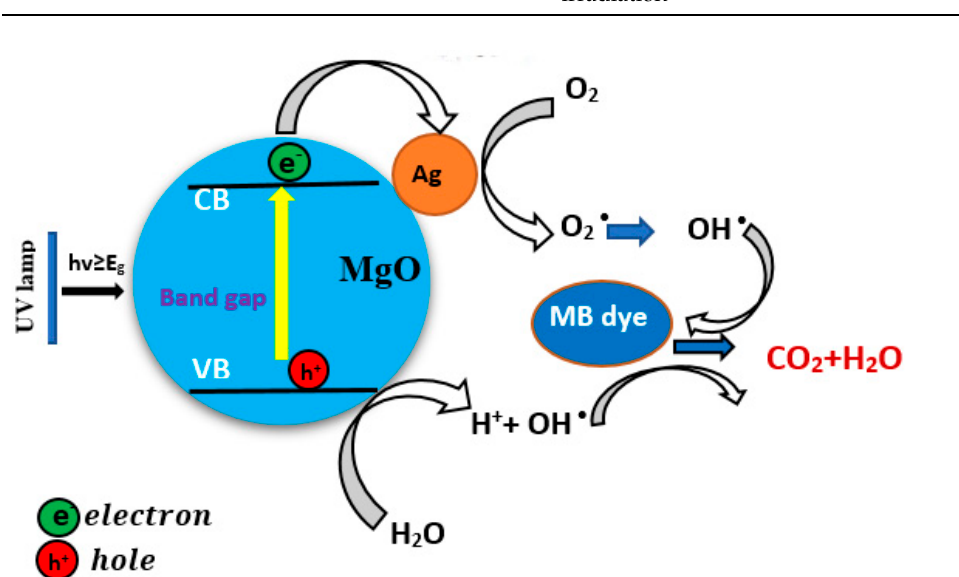
Figure 11. Diagram mechanism of photocatalytic process of Ag ‐ doped MgO